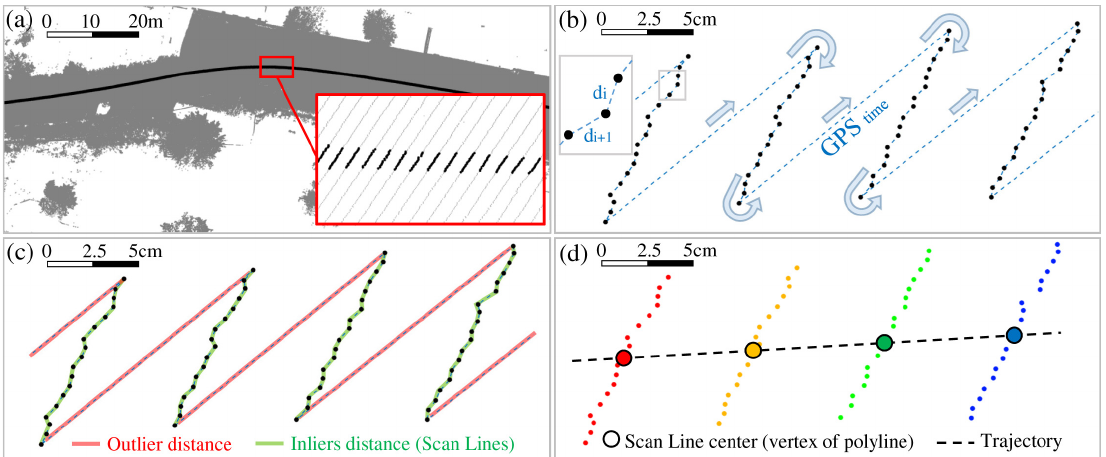
Figure 2. Trajectory extraction. ( a ) Top view of the point cloud of a single scanner, in black are the points with scan angles within the range [ − 1, +1], the red box shows a zoomed-in view; ( b ) Points sorted in ascending order according to GPS time; ( c ) Segments classified as outliers (highlighted in red) and segments classified as inliers (highlighted in green); ( d ) Extracted scan lines and their centroid, the black dashed polyline stands for the trajectory.